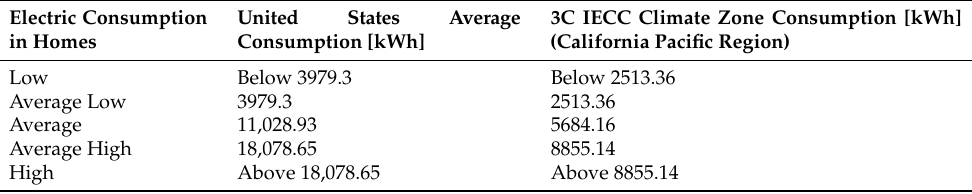
Table 3. Five types of home based on the electric consumption from the RECS data